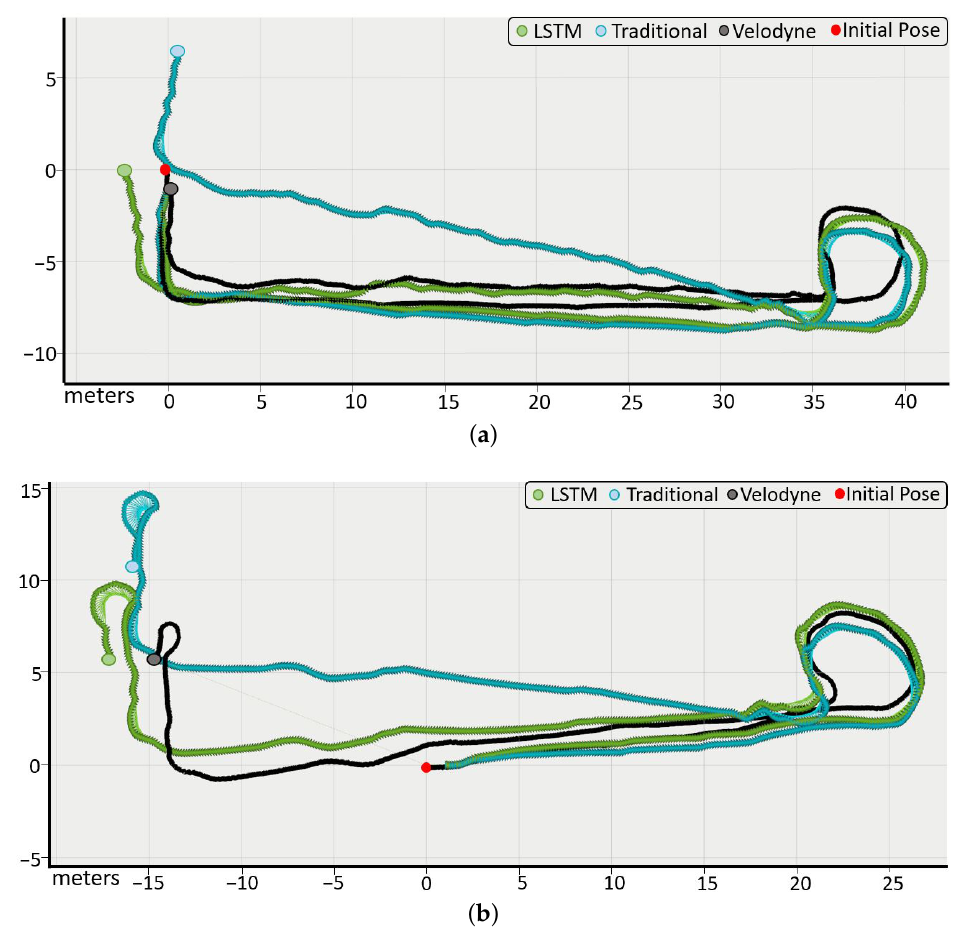
Figure 8. Paths to validate the odometry model proposed. Odometry with LSTM networks (green), traditional odometry (blue), and ground truth